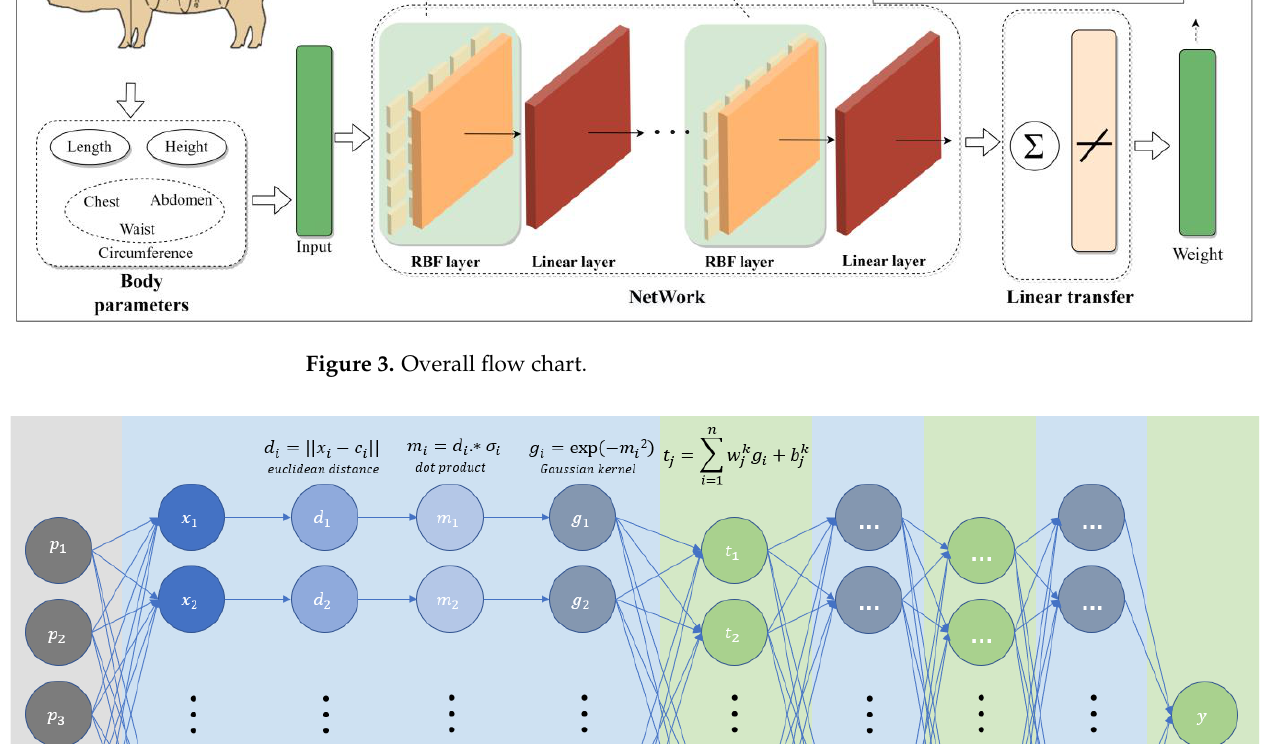
Figure 4. Our structure of the multilayer RBF network in this paper.